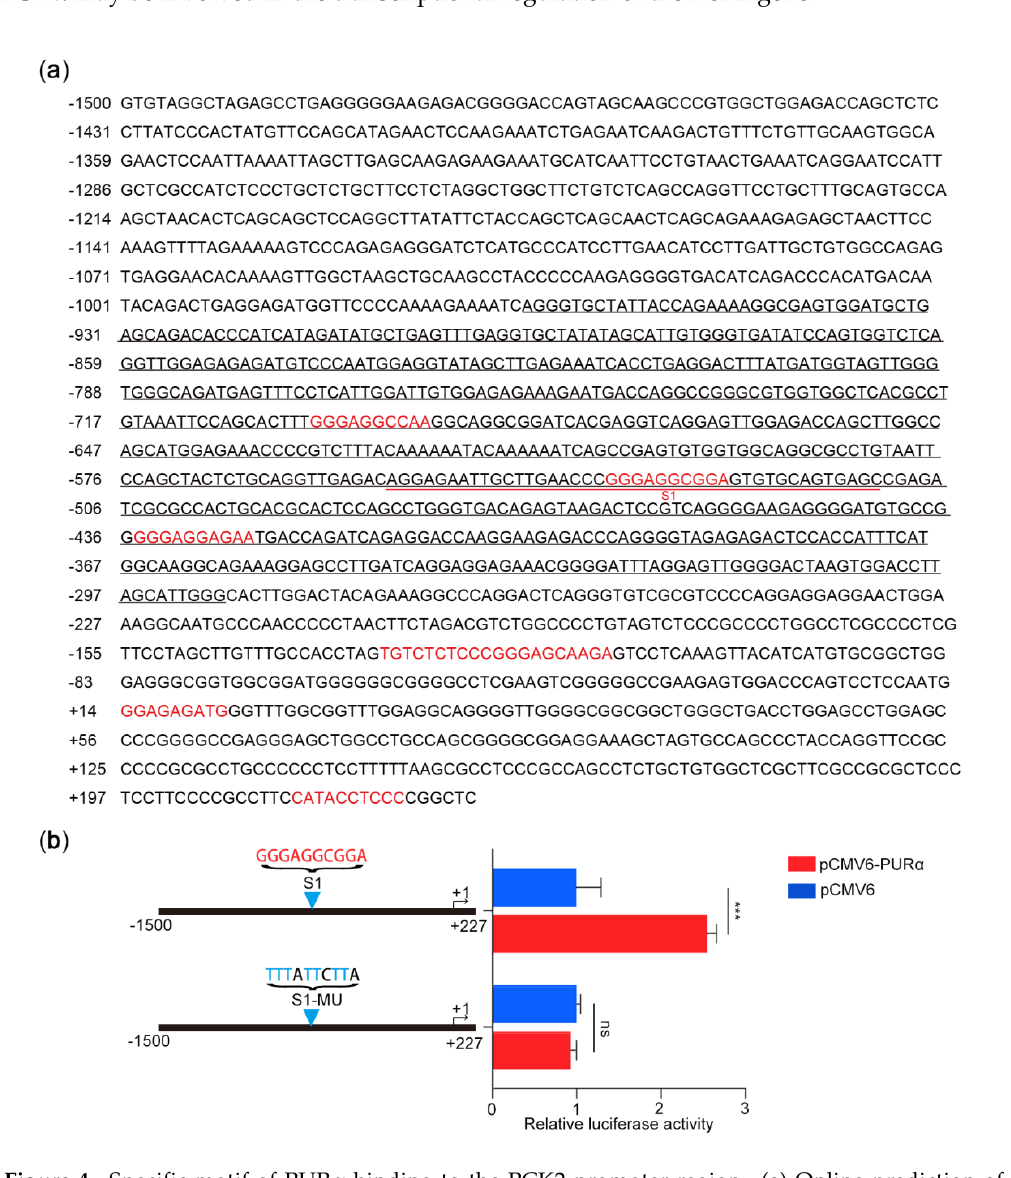
Figure 4. Specific motif of PUR α binding to the PCK2 promoter region. ( a ) Online prediction of the PUR α binding sites in the PCK2 promoter region ( − 1500 /+ 227). ( b ) Luciferase assay of the point mutant constructor at prediction site S1 in KYSE170 cells under exogenous overexpression of pCMV6 / pCMV6-PUR α . n = 3. ***, p < 0.001; ns, p >